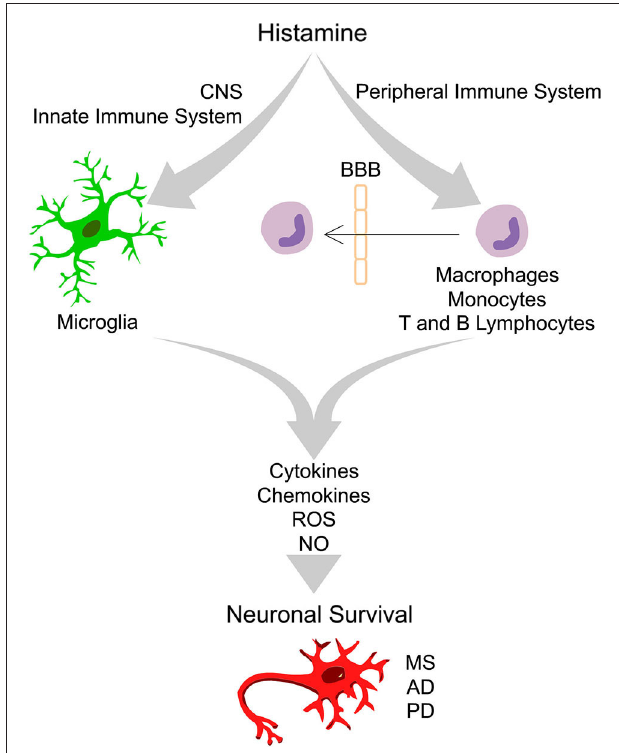
FIGURE 1 | Integrative scheme of the effects driven by histamine in peripheral and innate immune cells that ultimately may interfere with neuronal survival. In the healthy brain the “bulk” concentration of histamine is very low. Upon brain injury, degeneration or infection, the inflammatory response may trigger degranulation of mast cells, leading to a massive release of histamine in the blood and in the cerebrospinal fluid, leading to an increase of blood brain barrier (BBB) permeability. In this context, peripheral immune cells may cross the BBB and invade the brain parenchyma. Increased levels of histamine may activate distinct histamine receptors at peripheral (macrophages, monocytes, T and B lymphocytes) and innate immune cells (microglia) leading to the release of pro- or anti-inflammatory cytokines, chemokines, reactive oxygen species (ROS) and nitric oxide (NO). Histamine may thus have a dual role in the modulation of neuronal survival in the context of several neurodegenerative diseases, including Multiple Sclerosis (MS), Alzheimer’s disease (AD) and Parkinson’s disease (PD), depending on the type of histamine receptor activated, signaling pathways involved and factors